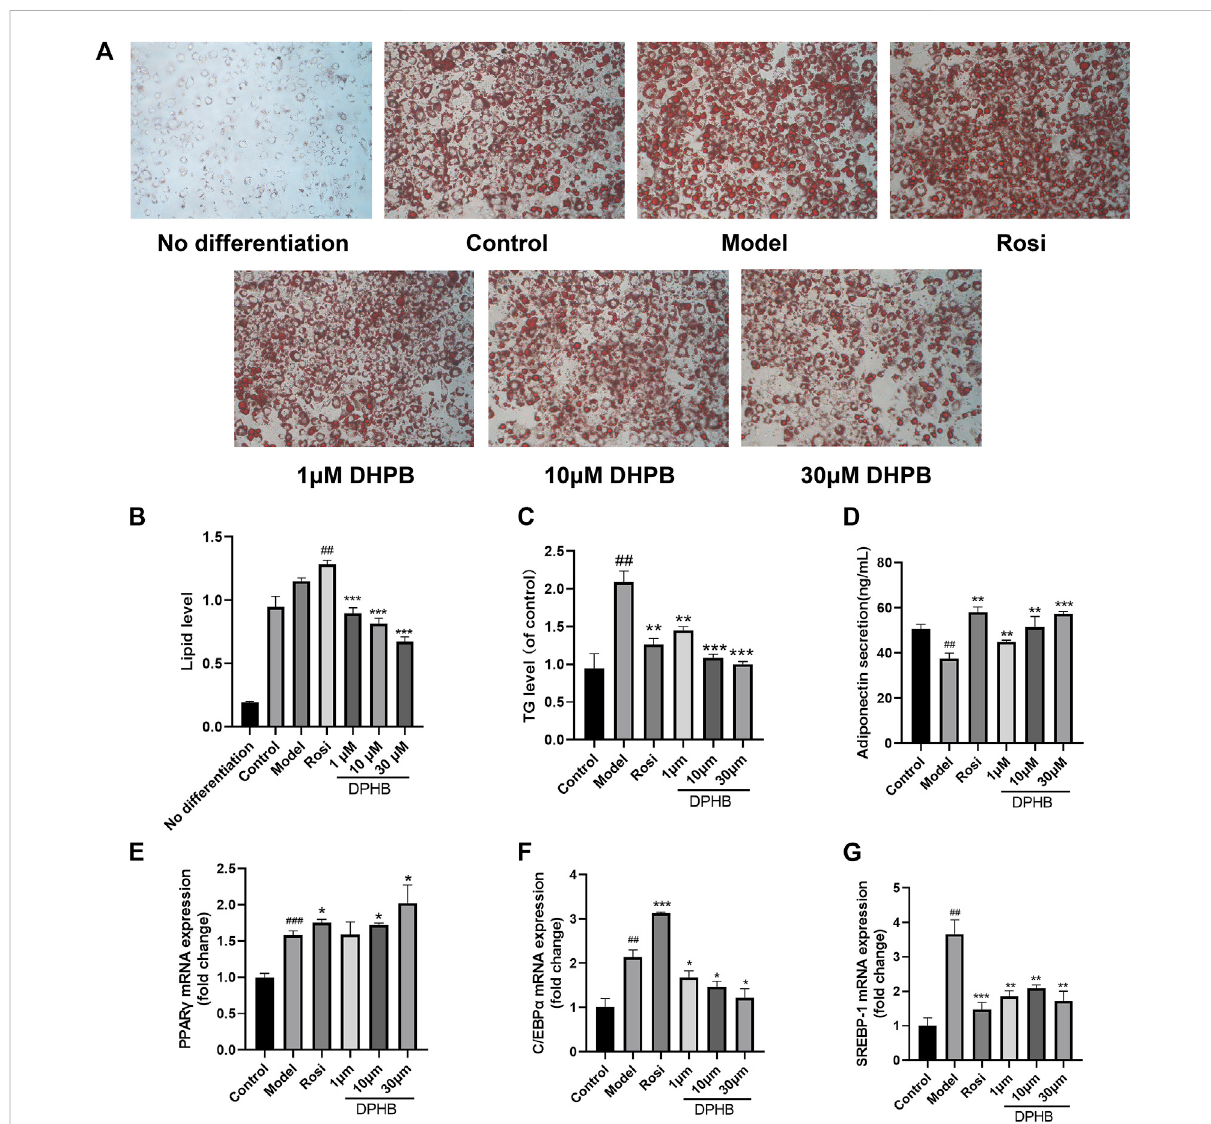
FIGURE 5 Effects of DPHB on lipid accumulation and adipokine expression in IR-3T3-L1 adipocytes. (A) Lipid accumulation was visualized by oil red O staining (magni fi cation: ×100); (B) quanti fi cation of the lipid drop dissolved in isopropanol by detection at 510 nm; (C) accumulation of triglycerides; (D) adiponectin secretion; (E – G) mRNA expression of PPAR γ , C/EBP α , and SREBP-1. All values are expressed as means ± SD, ( n ≥ 3). * p < 0.05, ** p < 0.01,and*** p < 0.001,whencomparedwiththemodelcontrolgroup;and ## p < 0.01and ### p <